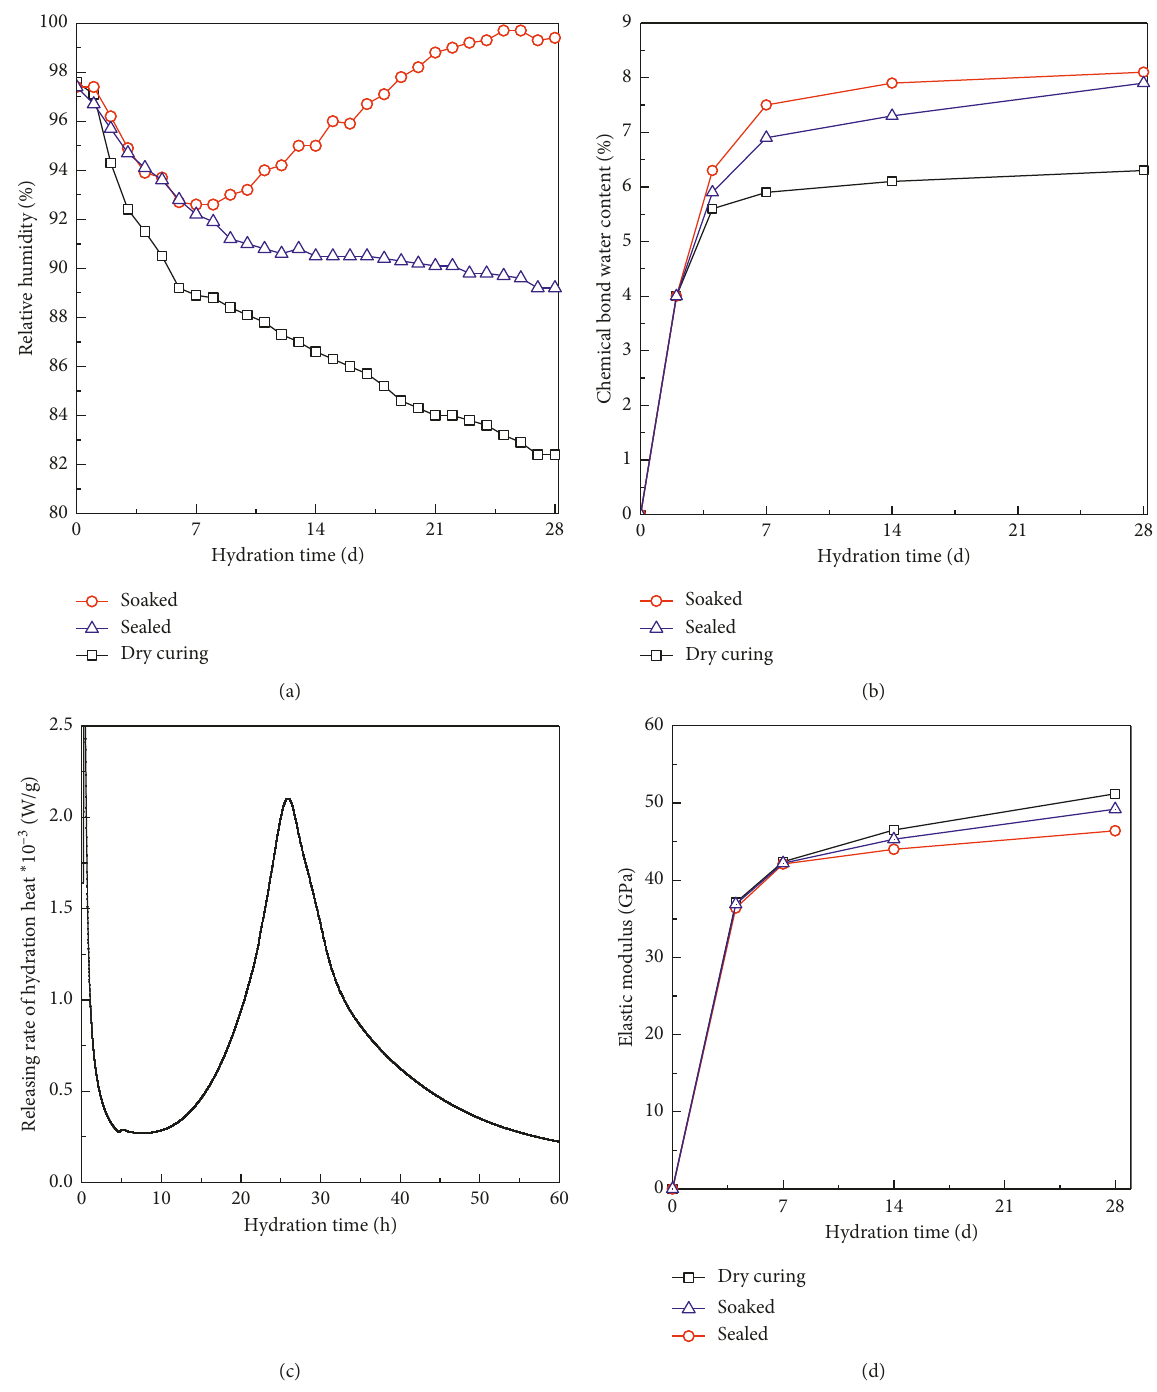
Figure 2: The chemical bond water, elastic modulus, relative humidity, and hydration heat of hardened slurry. (a) Relative humidity. (b) Chemical bond water. (c) Hydration heat. (d) Elastic